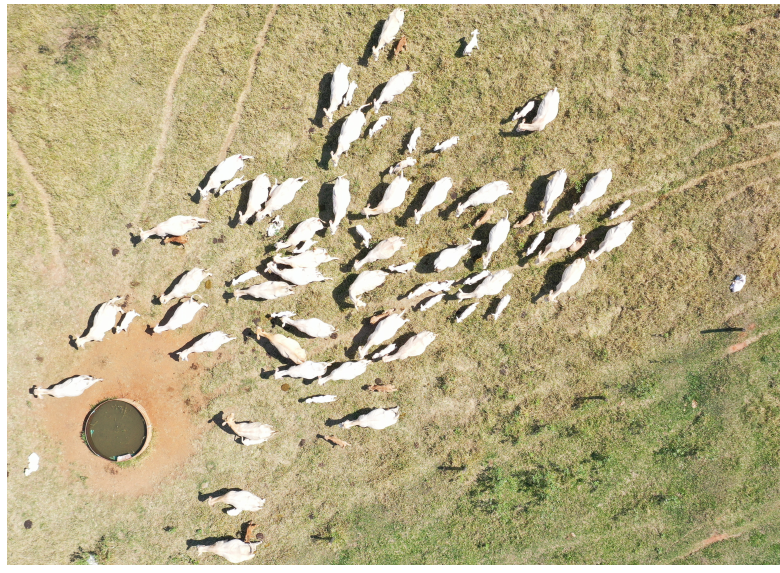
Figure 5. Example of image containing many calves.